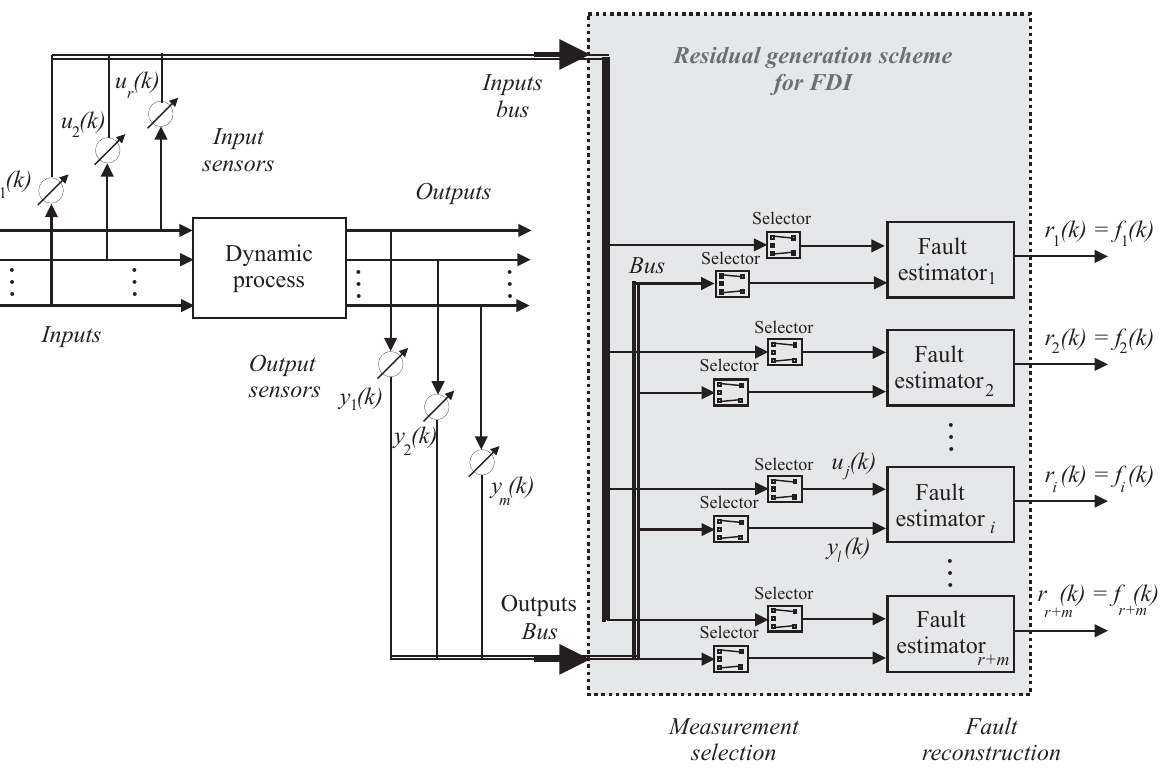
Figure 2. Bank of fault reconstructors for